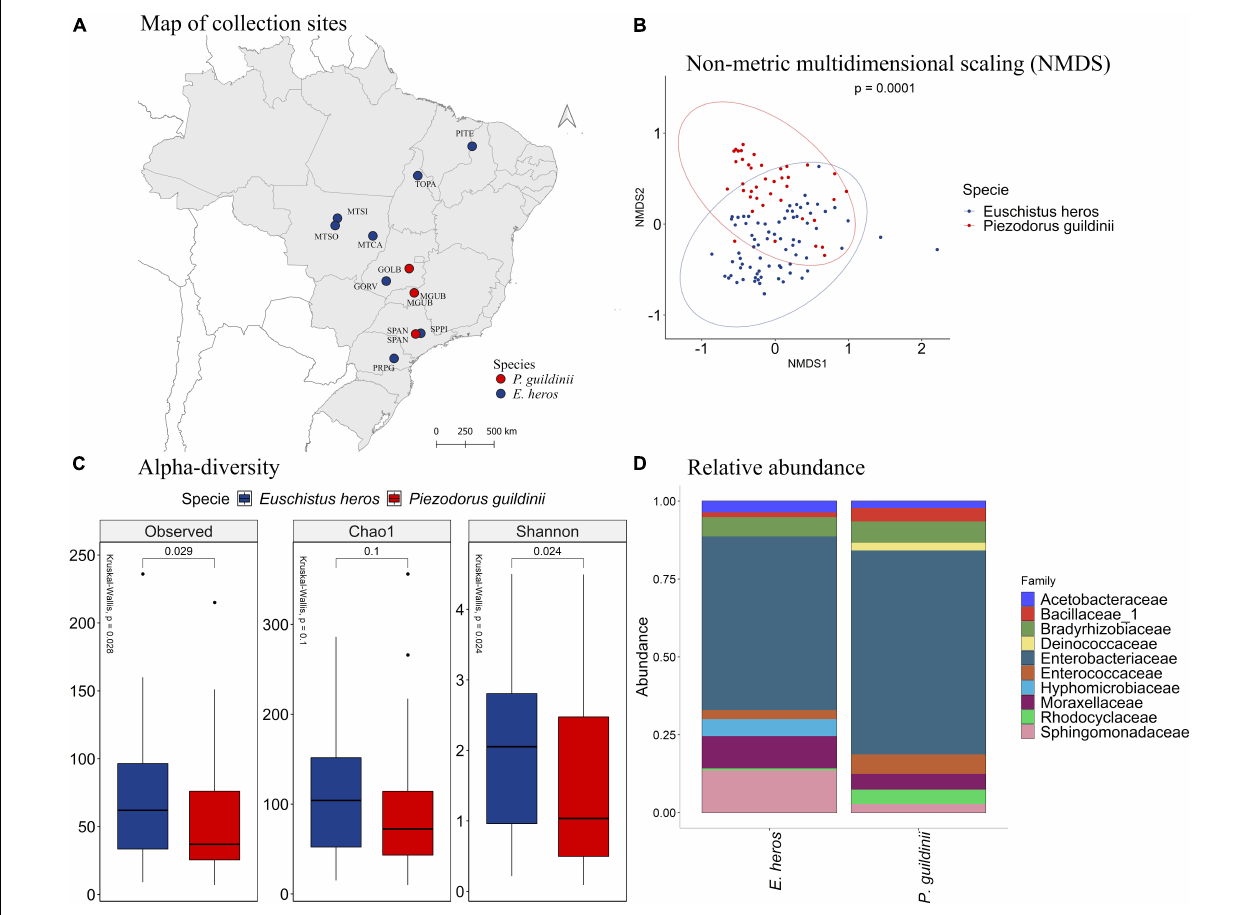
FIGURE 6 | (A) Mapping of collection sites of E. heros and P. guildinii , classified by species in Brazil. (B) NMDS of Bray-Curtis similarity matrix among 115 samples from the intestinal microbiome of E. heros and P. guildinii collected in Brazil. The ellipses are showing clustering between species. Multivariate analysis of variance (PERMANOVA) is indicated in the upper right. (C) Alpha diversity levels based on Observed OTU, Chao1 index and Shannon index for the different species. The non-parametric test (Kruskal–Wallis) is indicated in the upper left of each graph. Pairwise comparison (Wilcoxon) is indicated between Ecoregions. (D) Analysis of the ten most abundant bacteria families in the intestinal microbiome of E. heros and P. guildinii collected in Brazil, classified by species.